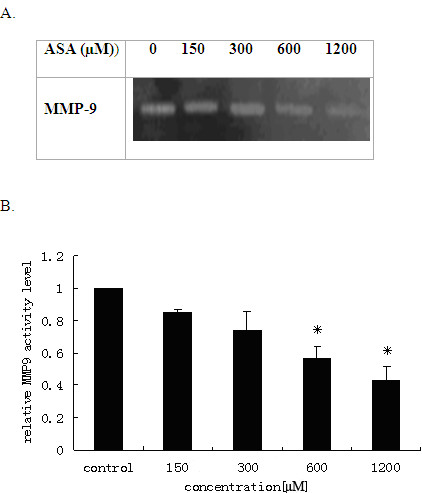
Dose effects of the ASA inhibition of MMP-9 activities released to media from THP-1 macrophages. The THP-1 macrophages were cultured in media containing 10% FBS with different concentrations of ASA for 24 h, and the activities of MMP-9 were measured by gelatin Zymography (A). Signal intensities from the zymographs were analysed by the Quantity One software and transformed to the bar graph (B). Results are expressed as mean ±S.D, of three experiments with duplicated samples. * P < 0.05,compared to control.